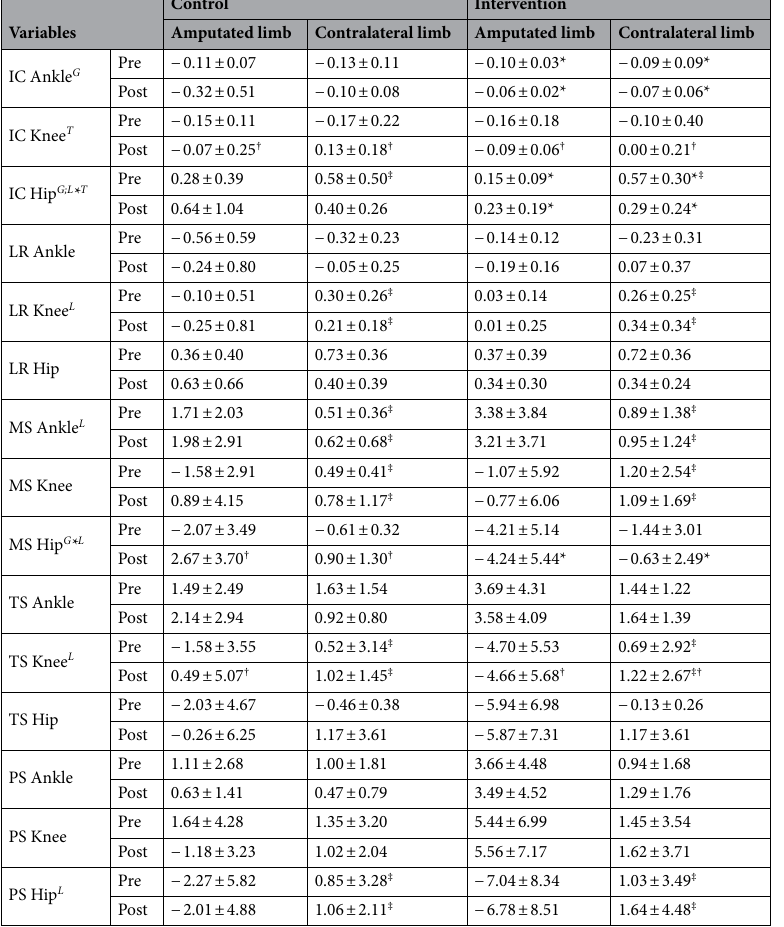
Table 5. Ankle, knee, and hip joint moment (Nm/Kg) in the sagittal plane during different phases of gait cycle, in amputees pre- and post-intervention. Phases of the gait cycle are abbreviated as: IC (0–2% GC)— ( +) and extension of the knee (-); Flexion ( +) and extension (-) of the hip. G Main effect of group ( P < 0.05); L Main effect of limb ( P < 0.05); T Main effect of time ( P < 0.05); G * L Group*limb interaction ( P < 0.05); L * T Limb*time interaction ( P < 0.05); * Between-group difference ( P < 0.05); † Pre-time difference ( P < 0.05); ‡ Amputated limb